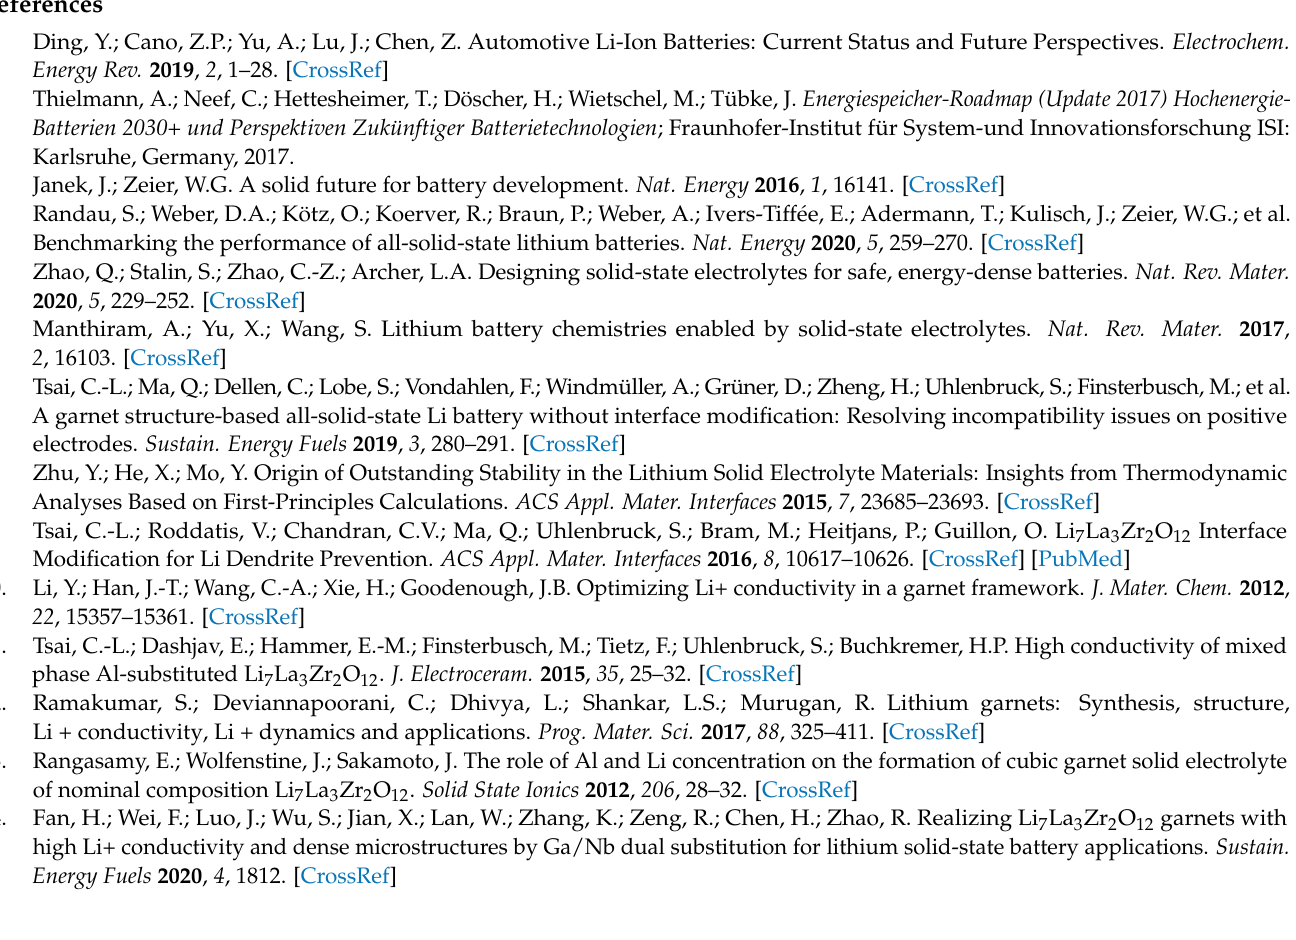
Table S1: Pellet mass and dimensions of the different sintered samples, Table S2: Results of the Rietveld refinements of the calcined